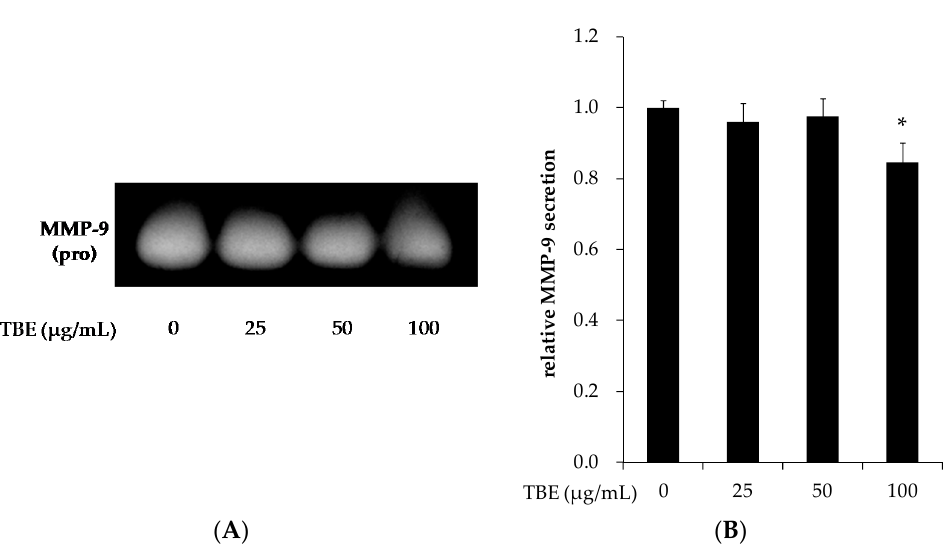
Figure 6. Effect of TBE on matrix metalloproteinase (MMP)-9 secretion in macrophages. THP-1 macrophages were incubated with 25–100 μ g/mL TBE for 24 h. MMP-9 secretion in culture supernatants ( A ) and its quantification ( B ) were analyzed by gelatin zymography. Values are means ± SD ( n = 3). * p < 0.05, compared to untreated control group.